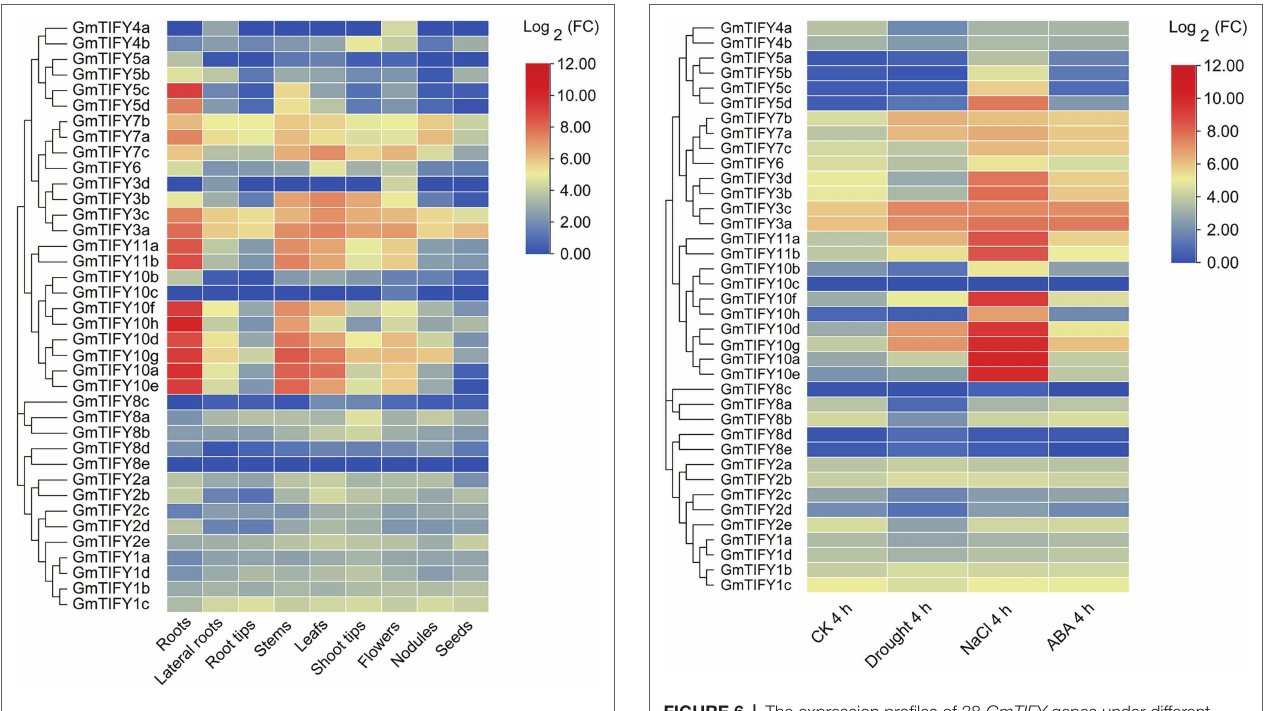
FIGURE 5 | The expression profiles of 38 GmTIFY genes in different soybean tissues. The expression data of 38 GmTIFY genes in different tissues were obtained from the Phytozome database.